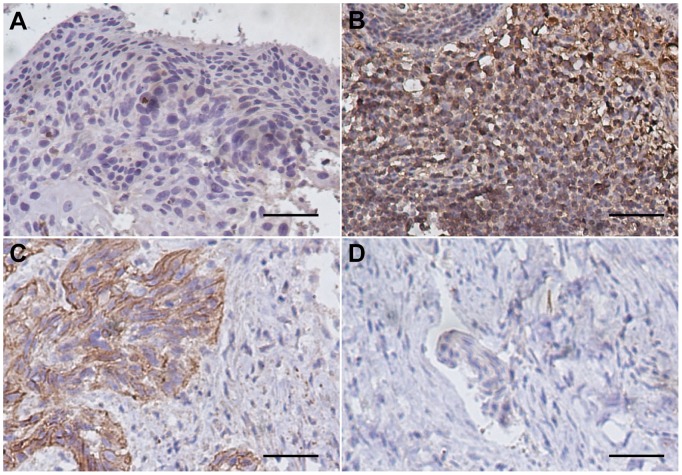
Representative immunohistochemical staining of STC1 in LSCC.Positive immunostaining was observed in the cytoplasm and membranes of tumor cells. (A) Negative expression of STC1 in adjacent non-cancerous epithelial tissues. (B) High expression of STC1 in well-differentiated glottic LSCC. (C) Low expression of STC1 in poorly differentiated supraglottic LSCC. (D) Staining with negative control (phosphate-buffered saline) in LSCC specimens. (magnification 200×, scale bar = 50 µm).